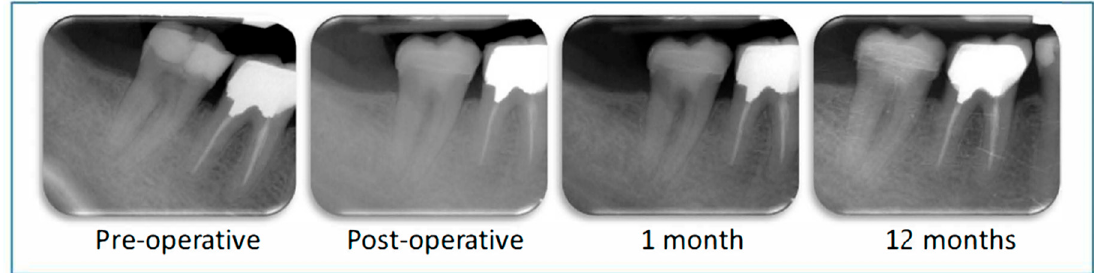
Figure 4. Radiological monitoring of tooth 47 during one year post-operatively. The Periapical Index (PAI) score remains at 1 throughout the follow-up period.